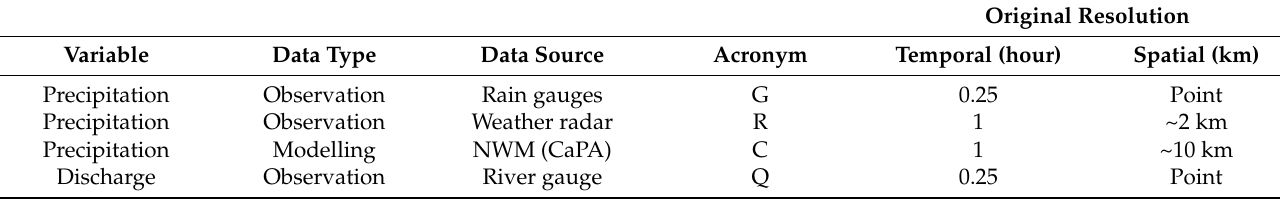
Table 1. Summary of the dataset used in this work.